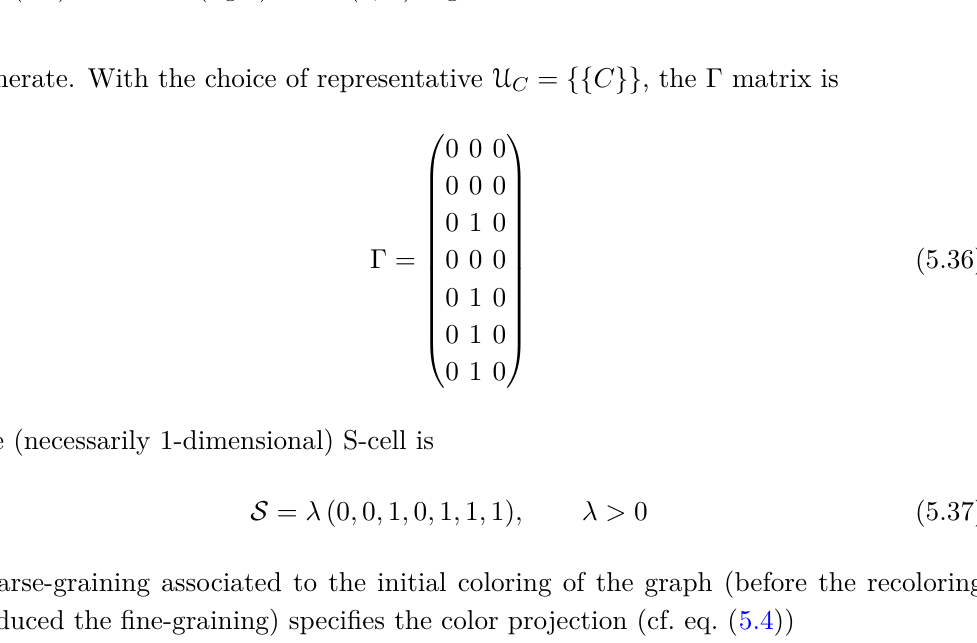
Figure 11. The W-cells for the topological graph model underlying the graphs in fig. 8, as well as variations of it obtained via the deletion of the appropriate edges. The figure shows the explicit dependence on the values of the weights as well as the degeneracy equations. The shaded insets show the topological graph models associated to the two diagrams, which are distinguished by the presence (left) or absence (right) of the ( σ, O )